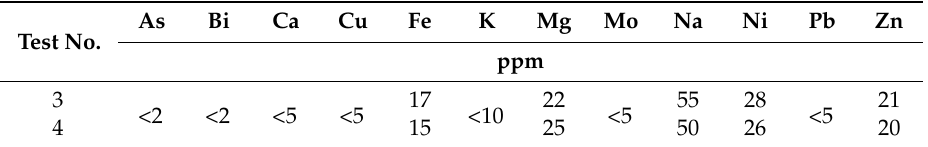
Table 11. Impurity contents in crystallized RbReO 4 .